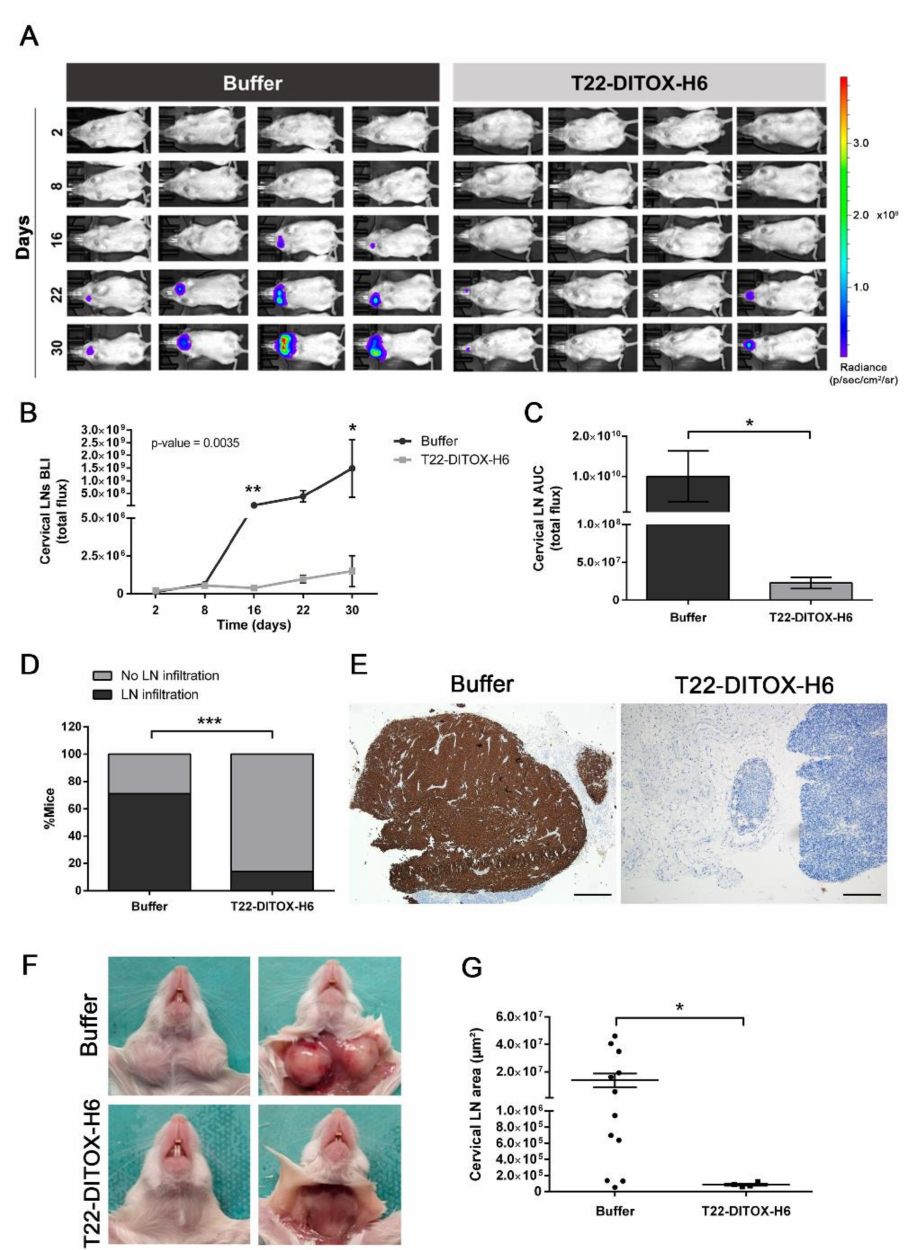
Figure 3. T22-DITOX-H6 repeated administration reduces the occurrence of regional dissemination to the cervical lymph nodes in a HNSCC-disseminated mouse model. ( A ) Bioluminescence intensity (BLI) emitted by 74B-Luci cancer cells during the experiment in the buffer- and T22-DITOX-H6-treated animals. ( B ) Semi-quantification of the emitted BLI in the cervical lymph nodes (LNs) throughout